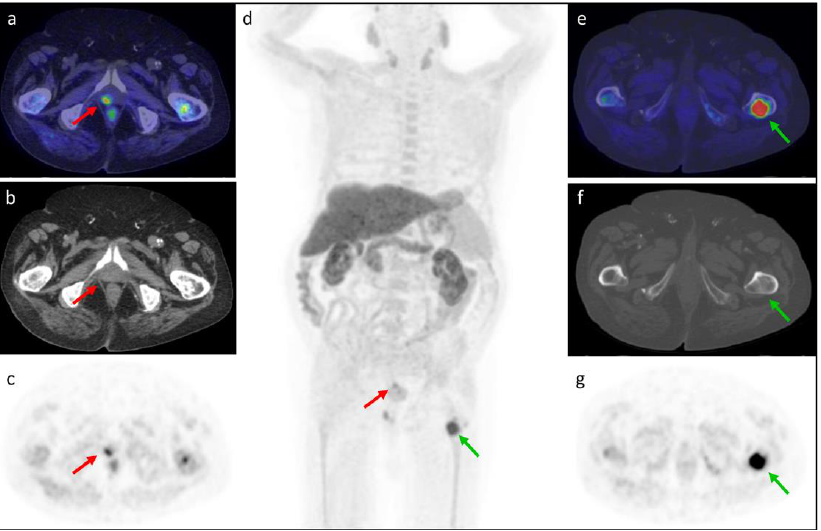
Figure 3. [ 18 F]fluciclovine PET/CT performed in a 75-year-old patient with BCR after radical prosta- tectomy (Gleason Score 7 = 4 + 3). At the time of the PET/CT, PSA rose to 0.89 ng/mL with PSAdt of 7.8 months. The (d) MIP, (a – c) axial (a: fused PET/CT, b: CT, c: PET) and (e – g) sagittal (e: fused PET/CT, f: CT, g: PET) images showed a locoregional recurrent lesion in left prostatectomy bed (red arrow) with SUVmax 8.6.